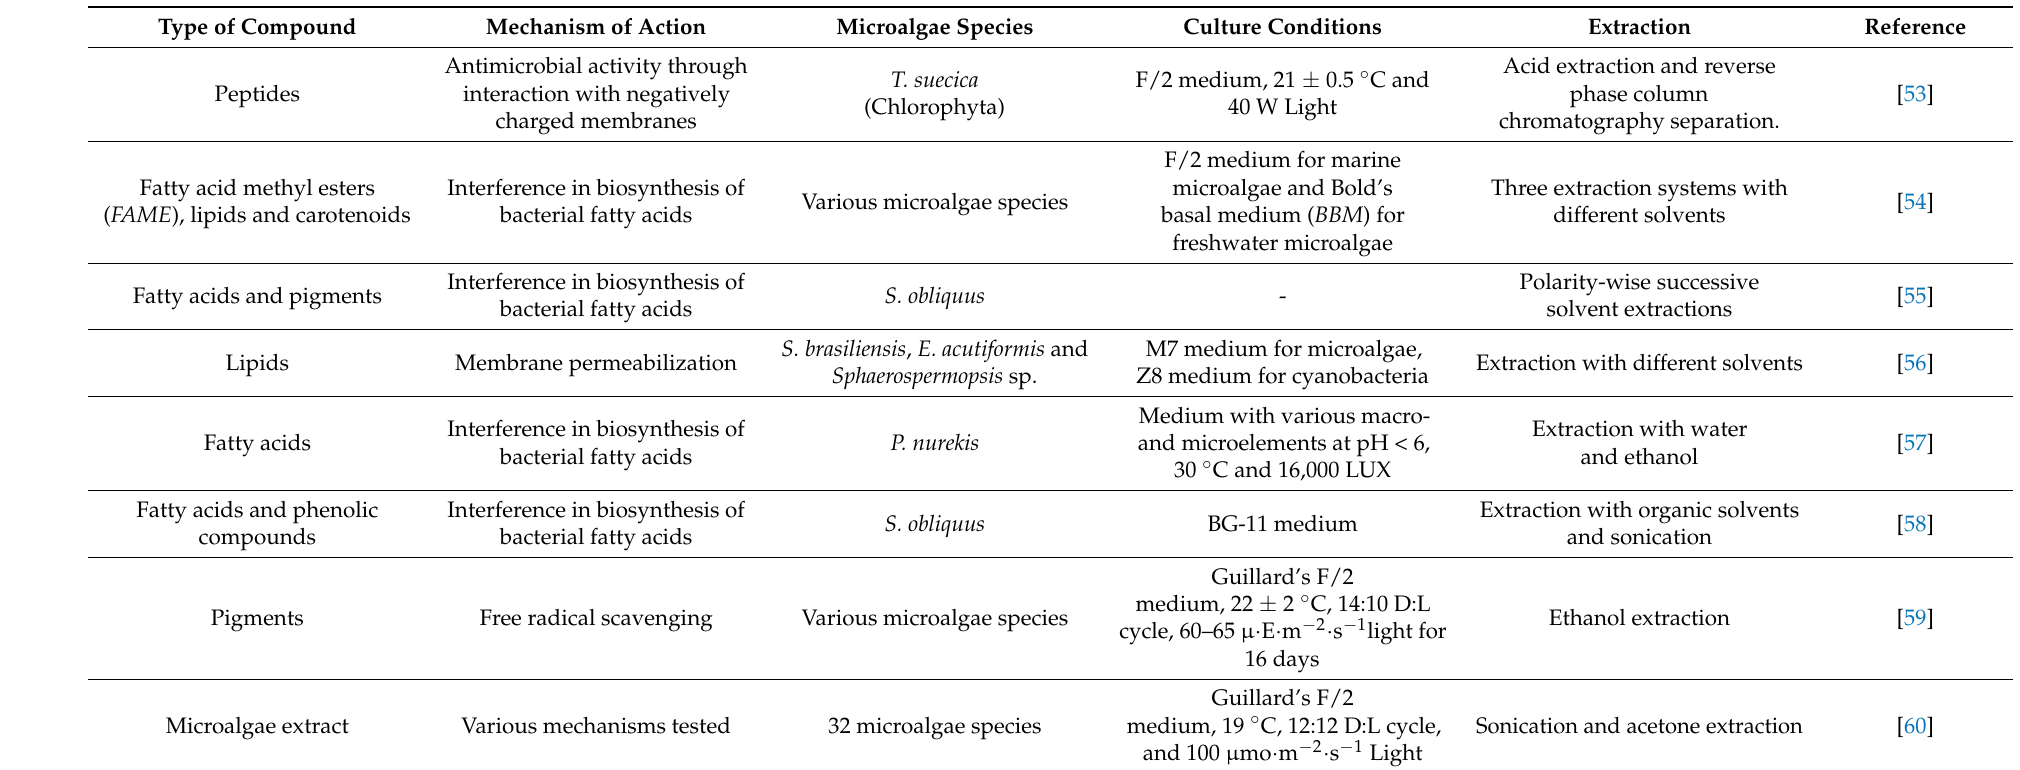
Table 1. List of compounds with immunomodulatory activity obtained from